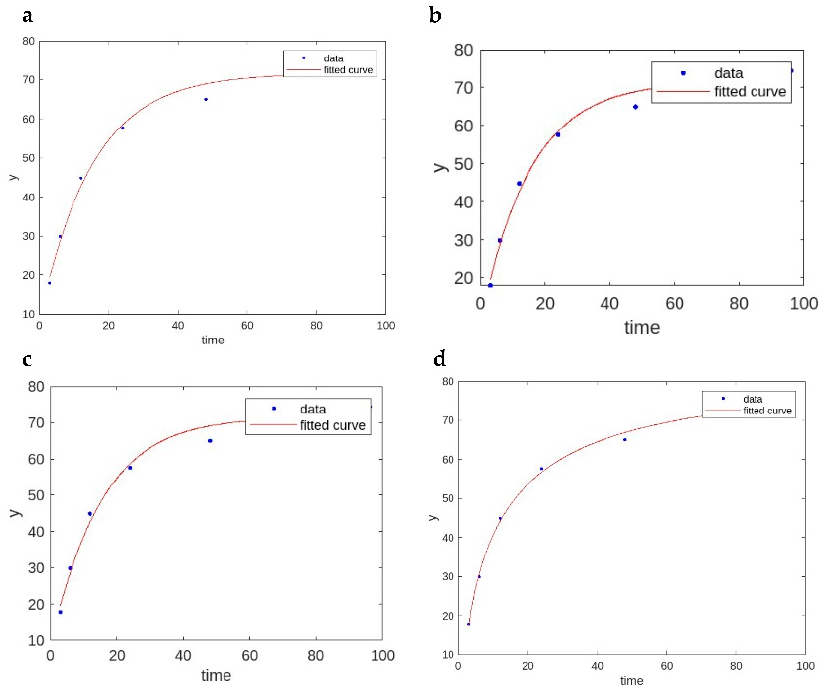
Figure 5. Ruminal fermentation curve for clover forages. ( a ) Model I, ( b ) Model II, ( c ) Model III, and ( d ) Model IV; X = incubation time, Y = fermentation amount.